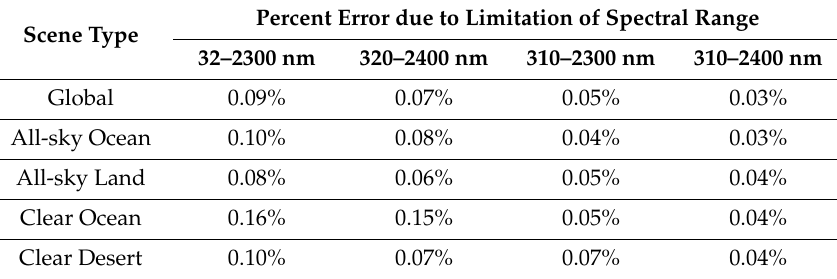
Table 4. Estimated error in total reflected solar